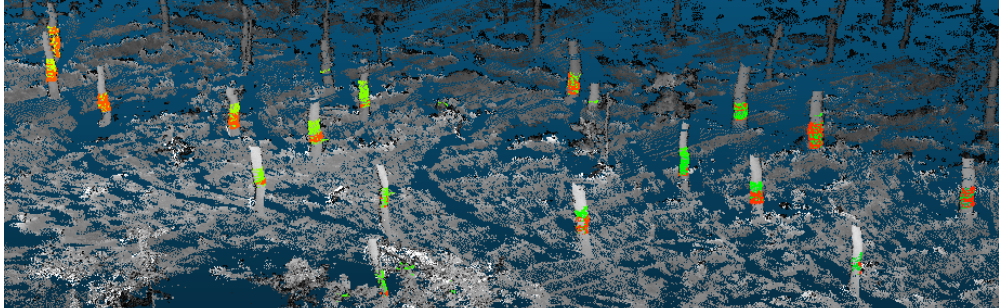
Figure 15. A view from the Malmköping 2 test area. The co-registered point cloud is grey; the green points clustered as stem points; and the red points are finally used for DBH estimation. Trees more than 10 m from the sensors trajectory can be detected as trees if they are not occluded.